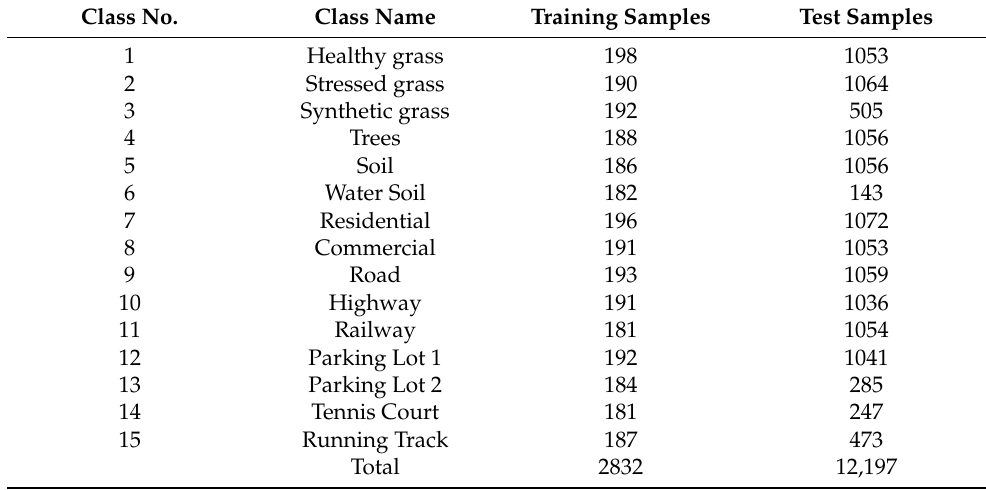
Table 1. The number of training and test samples used in the Houston 2013 dataset. Class